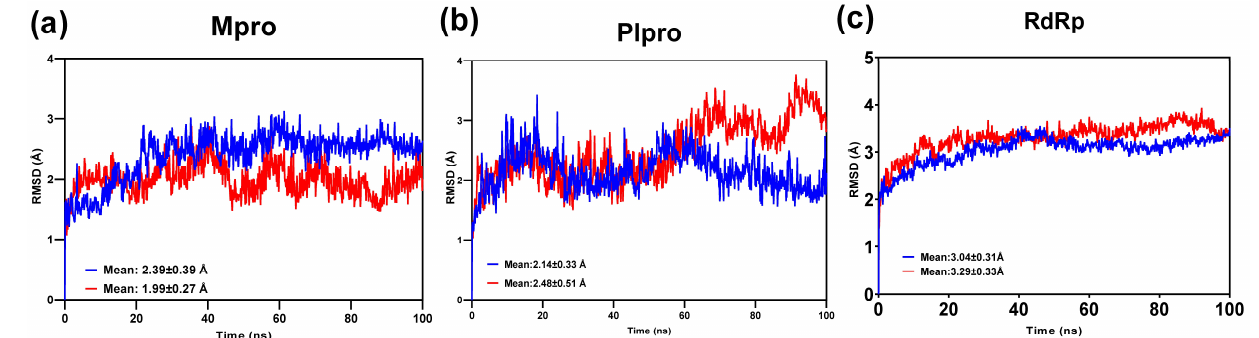
Figure 5. RMSD trajectories of ligand-bound proteins analyzed relative to C-α atoms over the 100 ns MD simulation. The RMSD trajectories for the ( a ) Ligand-bound Mpro protein, ( b ) Ligand-bound PLpro protein, and ( c ) Ligand-bound RdRp protein. The RMSD values for the 2751796 phytocompound and the respective reference compounds are illustrated in red and blue colors, respectively.